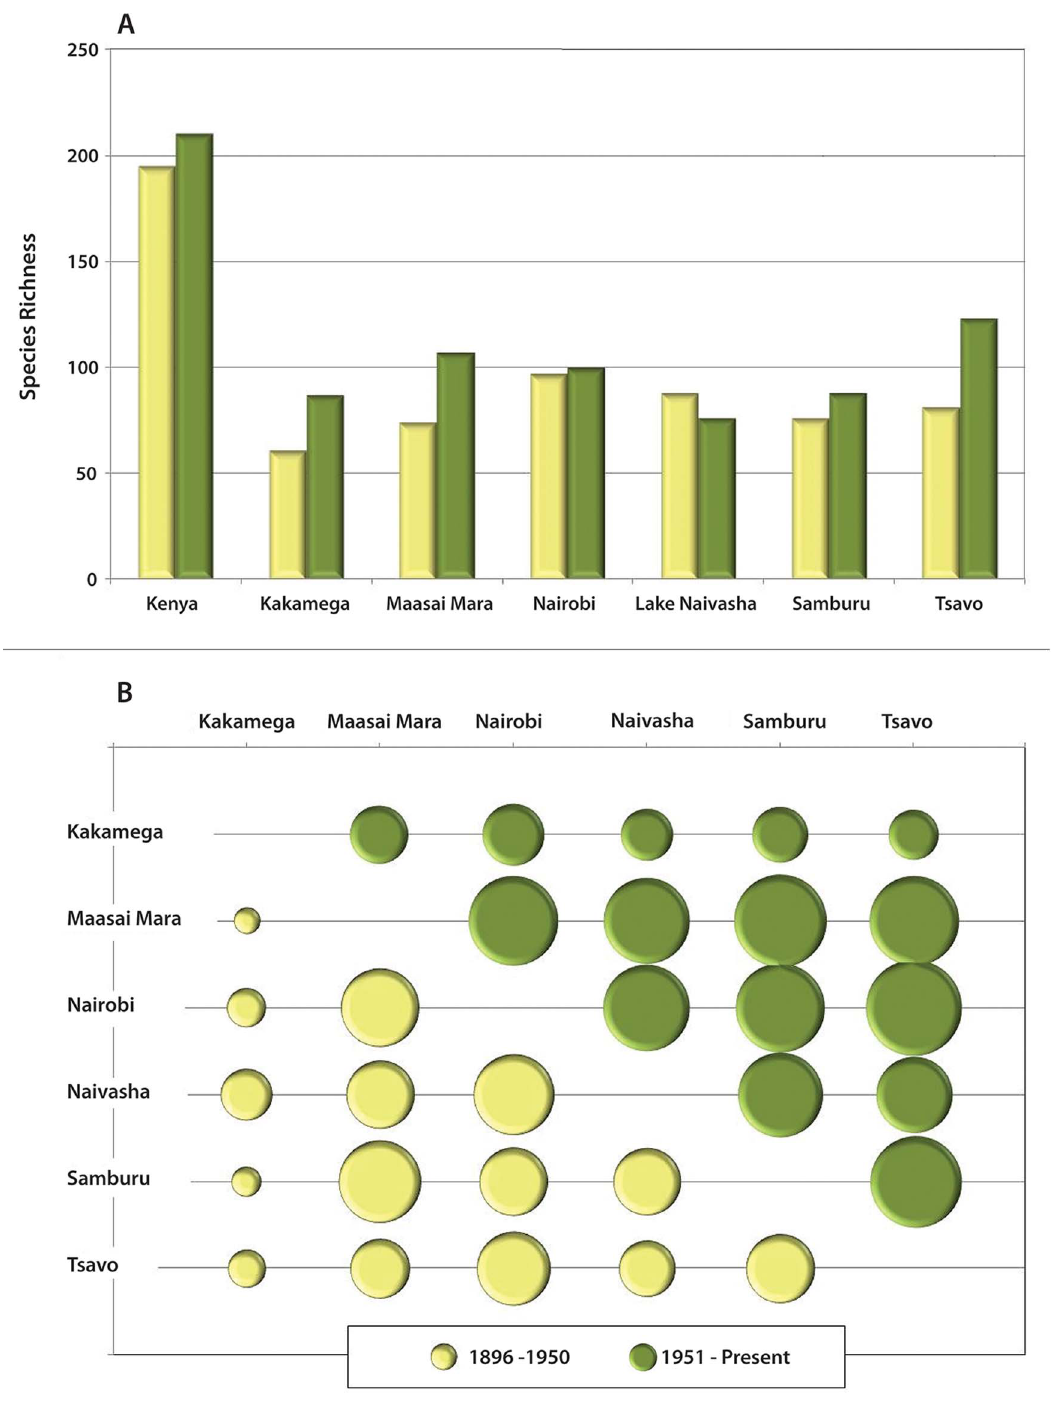
Figure 3. Richness and b -Diversity. (A) Comparison of species richness by site. Color code: yellow=1896–1950, green=1950–2013. A paired t-test indicates this is a significant increase in richness when considering all sites (t=2.215, p=0.039). (B) Degree of similarity between each pair of sites in the historical and modern records, using the Sorensen Index. Size of filled circles indicates degree of similarity for each pair (See Table S3 in File S1 for exact values). Comparisons of circles in different time periods show an increase in similarity for each site pair, thus a decrease in beta-diversity (Table S4 in File S1). Wilcoxon signed-rank test: p , 0.0001. Population Density vs. Occupancy As an additional strategy to detect sampling biases, we used the presence/absence data in our 6 sampling areas to calculate